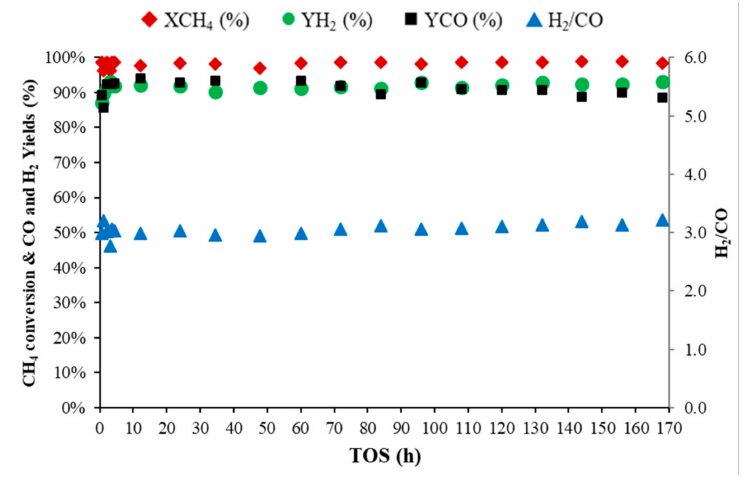
Figure 7. Catalytic performances of Ni-UGSO on SRM (H 2 O/CH 4 = 1.7, 900 ◦